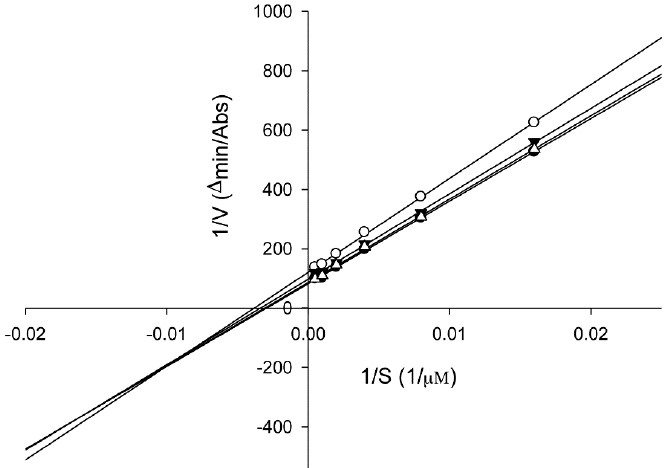
Figure 6. Lineweaver-Burk plots of cellular tyrosinase in the absence and presence of 3,4-dihydroxy-5-methoxybiphenyl-2 ′ - O - β - D -glucopyranoside ( 13 ). Data were obtained as mean values of 1/ V , the inverse of the increase in absorbance at 495 nm·min − 1 ( ∆ OD 495 min − 1 ). Cells (1 × 10 5 ) were treated with different doses (60, 80, and 100 μ M) of compound 13 for 24 h and harvested. Proteins (40 μ g) were incubated with L -DOPA at a final concentration of 62.5, 125, 250, 500, 1000, and 2000 μ M for 1 h at 37 °C. Three independent tests were conducted with different concentrations of L -DOPA as the substrate. The absence ( ● ); and presence of compound 13 at 100 μ M ( ○ ); 80 μ Μ ( ▼ ); or 60 μ M ( ∆ ).